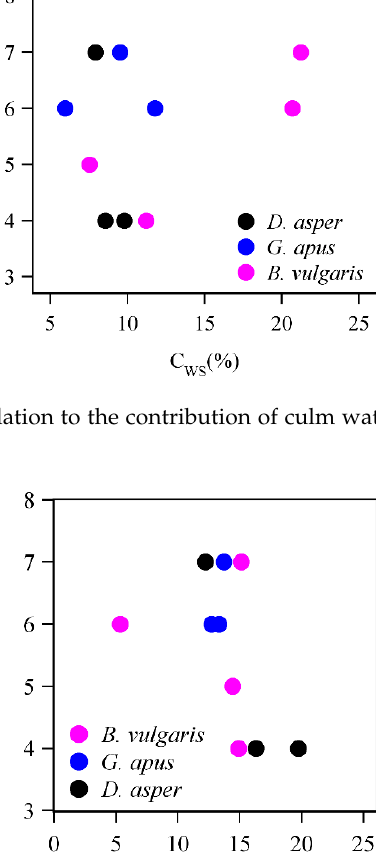
. Table A2. Result of the analysis of variance (ANOVA) among the unbalanced data. The tested water transport characteristics based on deuterium tracing on four culms for B. vulgaris and three culms for G. apus and D. asper : times when deuterium arrived in the canopy ( T arrival , days), reached the maximum concentration ( T max , days) and amount of time it remained in the bamboos ( T residence , days). Derived daily water use (WU D2O , kg day − 1 ) and daily sap velocity ( V D2O , m day − 1 ). ‘ P > 0.05 ( P r > F )’ indicate equal variance among species. Dependent